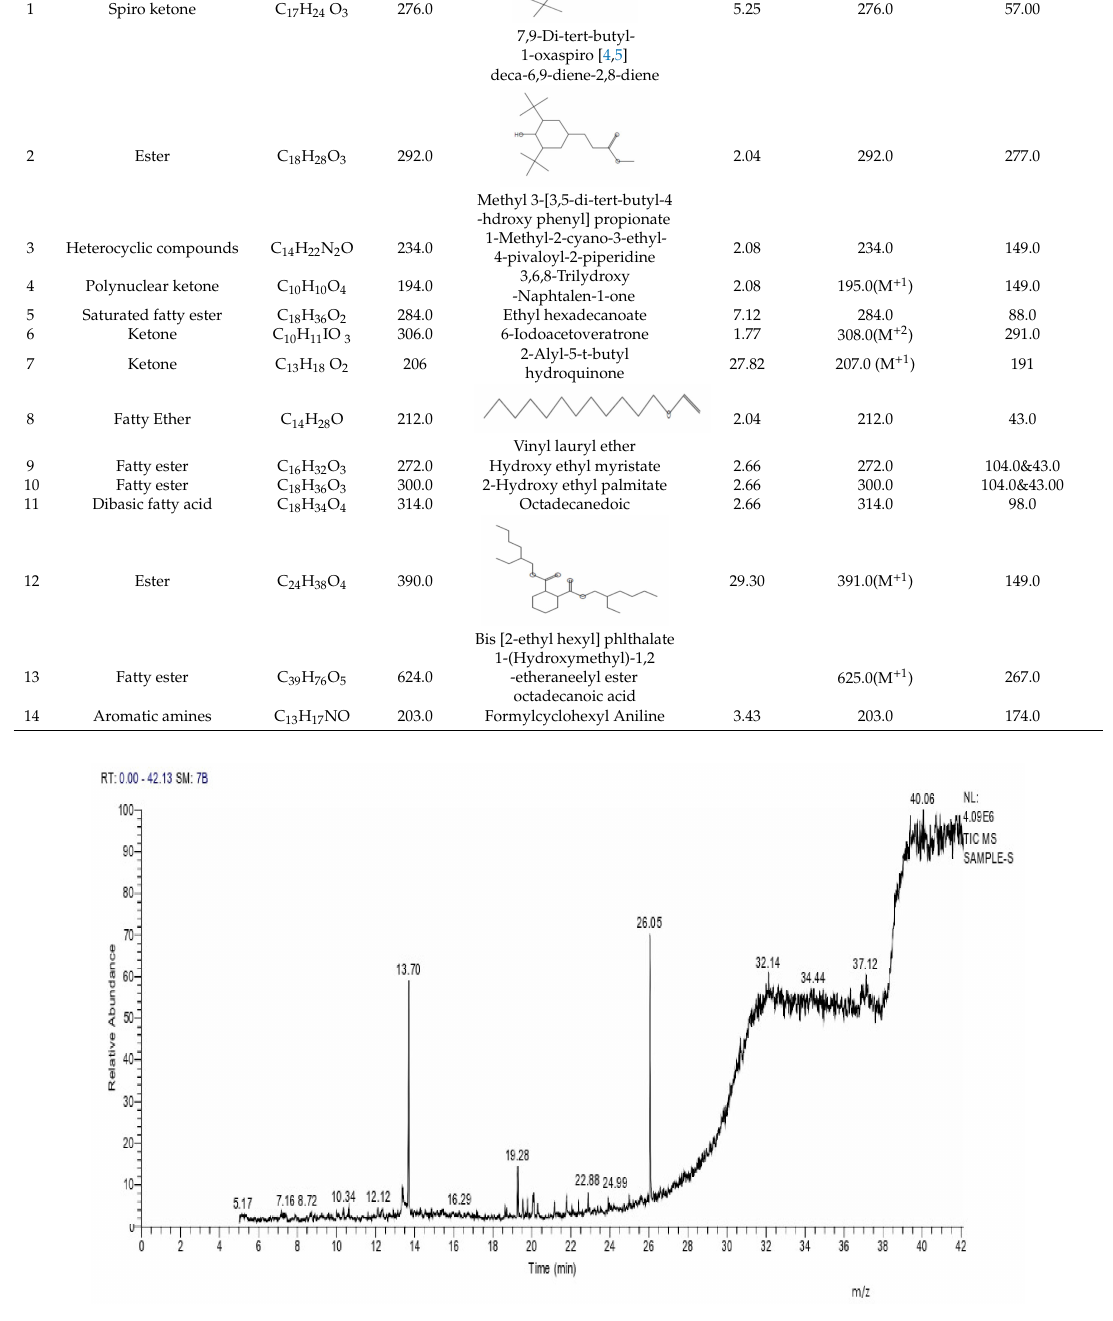
Figure 7. GC-MS analysis of